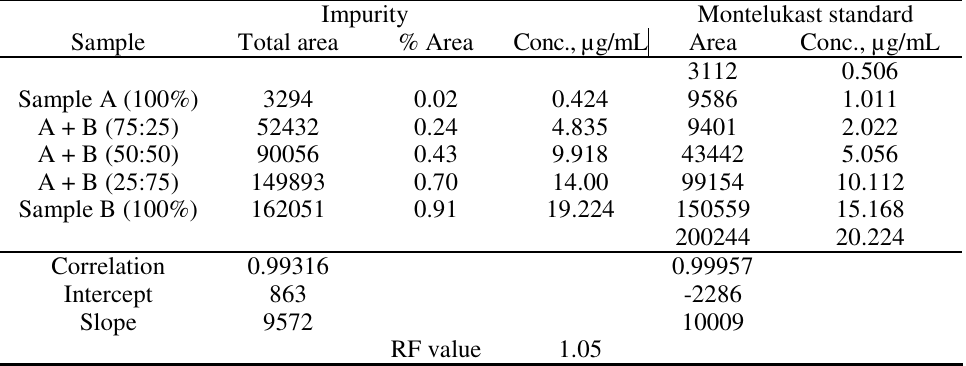
Table 2. Determination of RF value of unknown impurity (Approach-1)